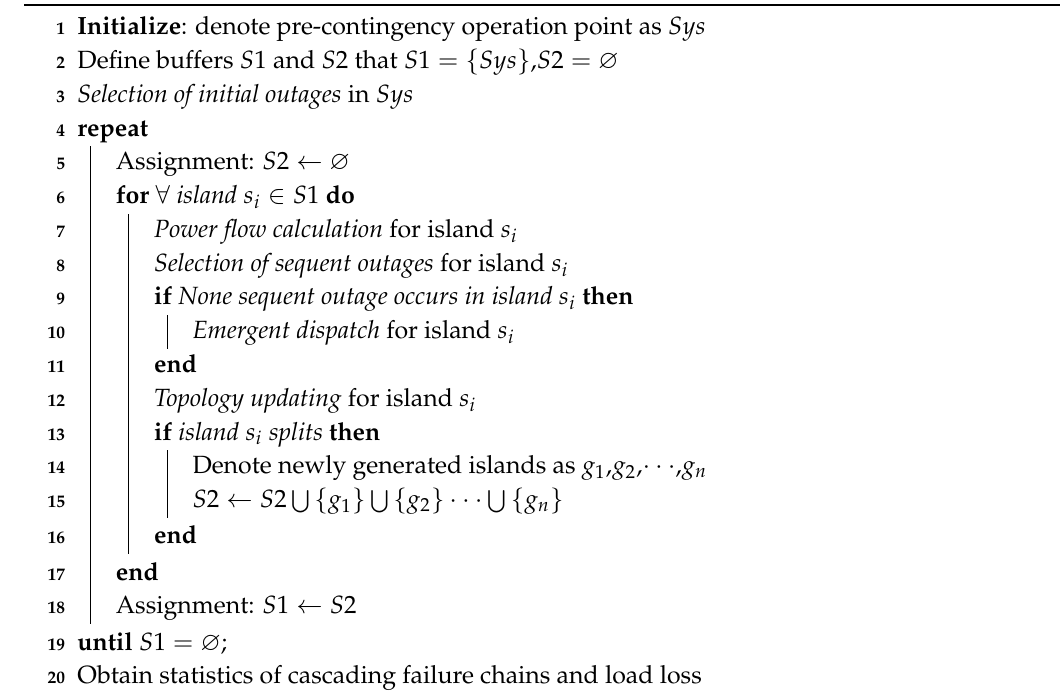
Algorithm 1: Pseudocode of Cascading Failure